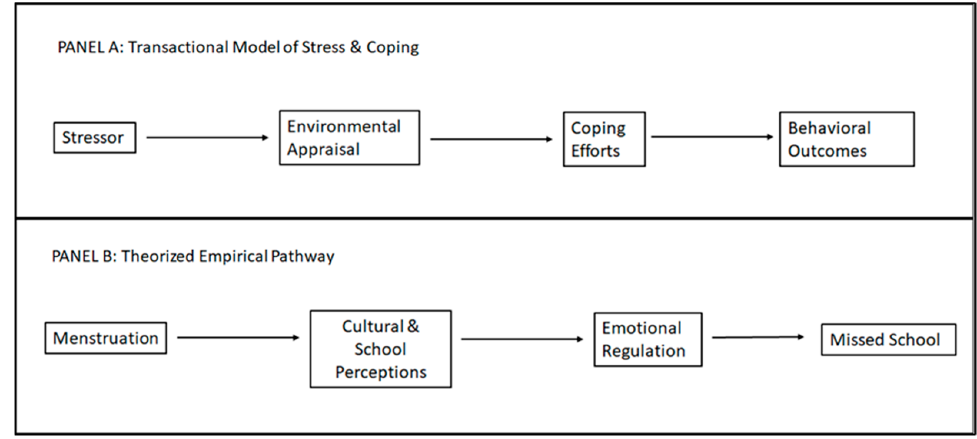
Figure 1. Conceptual framework.